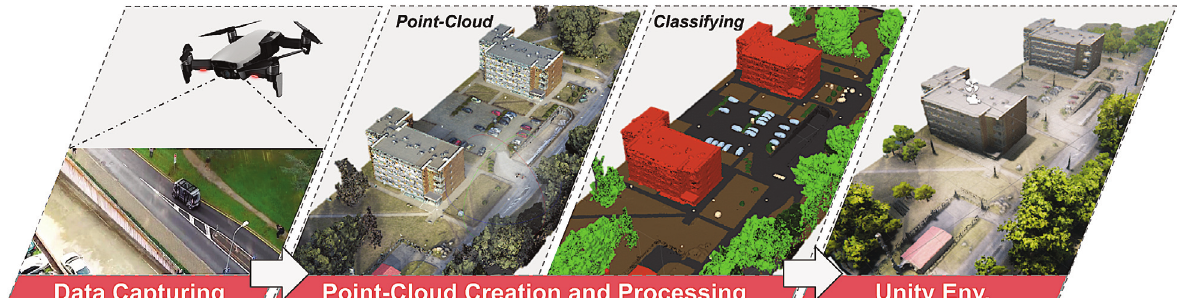
Fig. 4. Steps for virtual environment